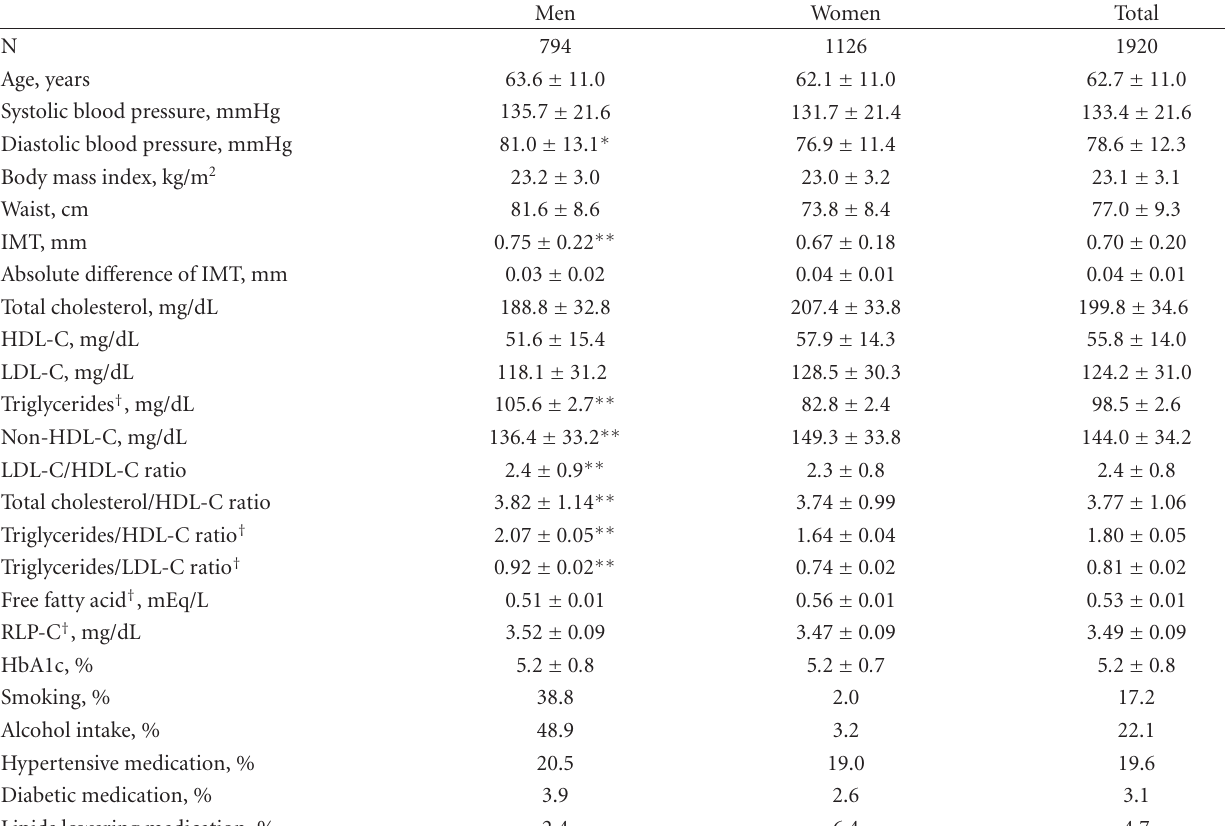
Table 1: Characteristics of subjects at baseline in